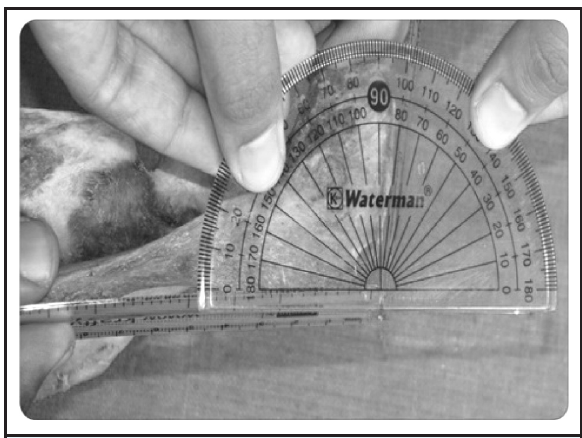
Figure 4. Measurement of Lateral Angle. 4. Medial angle:It was measured as the angulation of the bone formed at the medial end of the anterior border of the crest of the spine of the scapula where the plate like body of the bone is bent between the medial borders of the supraspinous and the infraspinous fossae. 2 For measuring this angle a scale was placed along the supraspinous line and another scale was placed along the infraspinous line and an angle between both was measured with the help of protractor (Figure 1 and5).